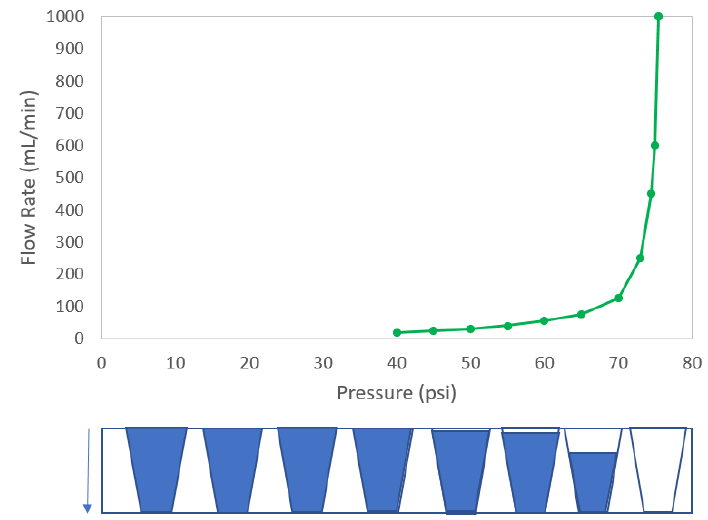
Figure 1. Hypothetical bubble point curve for an asymmetric membrane. Bottom illustration shows liquid level in idealized conical pores (representing the largest pores within the pore size distribution) corresponding to the pressure differential across the pores. Arrow indicates direction of applied pressure.